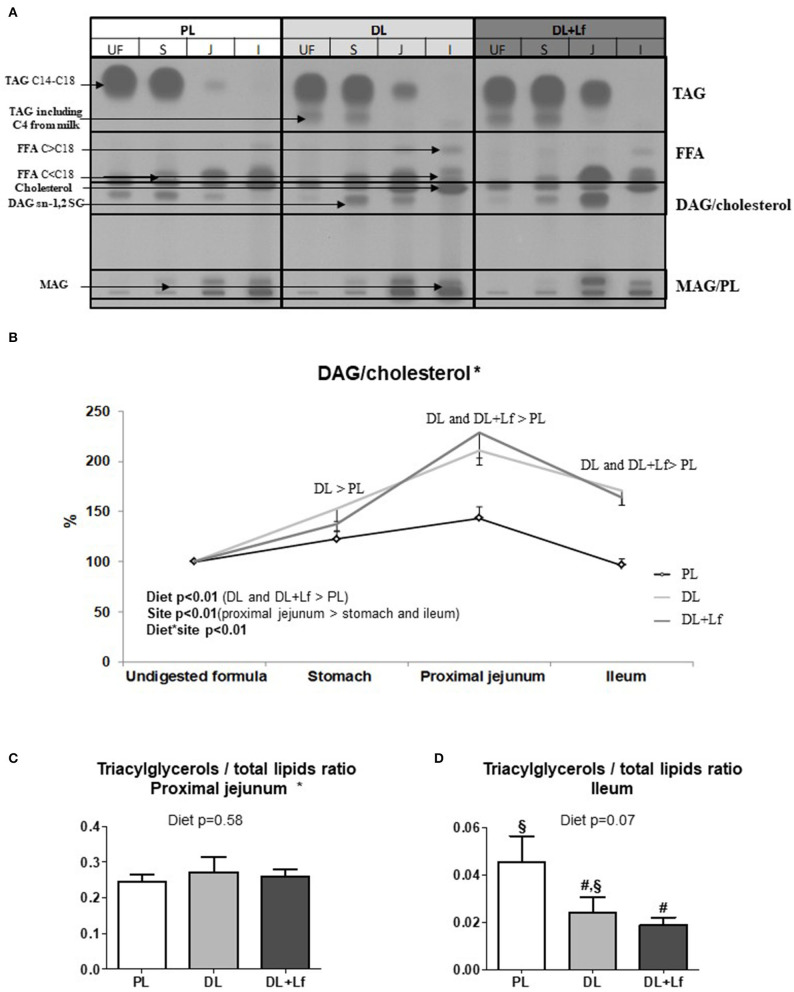
Gastric and intestinal lipolysis of PL, DL, and DL+Lf formulas. (A) Example of thin-layer chromatography showing the evolution of lipid classes between stomach (S), proximal jejunum (J), and ileum (I) 90 min postprandially compared to undigested formula (UF). (B) Longitudinal evolution of DAG/cholesterol along the intestine based on the undigested infant formula content. All written effects were significant (p < 0.01). (C) Triacylglycerols/total lipids ratio in proximal jejunum and (D) in ileum. Labeled bar charts without a common symbol differ (p < 0.1). Formulas contained as lipids either only plant lipids (PL, n = 7–8), a half-half mixture of plant and dairy lipids (DL, n = 6–8), or a half-half mixture of plant and dairy lipids supplemented with Lf (DL+Lf, n = 6–7). TAG, triacylglycerol; FFA, free fatty acids; SC, short chain; DAG, diacylglycerol; MAG, monoacylglycerol; PL, polar lipid. Data are expressed as the mean ± SEM. *DAG/cholesterol: p(diet * sex) = 0.04 (DL and DL+Lf females > PL females, DL, and DL+Lf male piglets > PL male piglets); TAG/total lipids ratio in proximal jejunum: p(diet * sex) = 0.02 (DL males > DL females) and p(sex) is not significant.